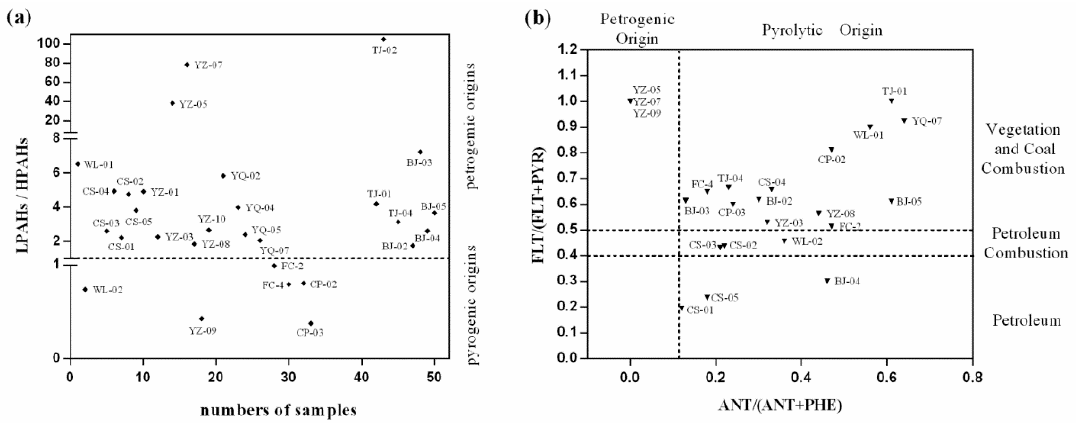
Figure 3. Sources identification: ( a ) concentration ratios of LPAHs/HPAHs; and ( b ) PHE) vs. FLT/(FLT + (ANT/(ANT + PHE) vs. FLT/(FLT + PYR).